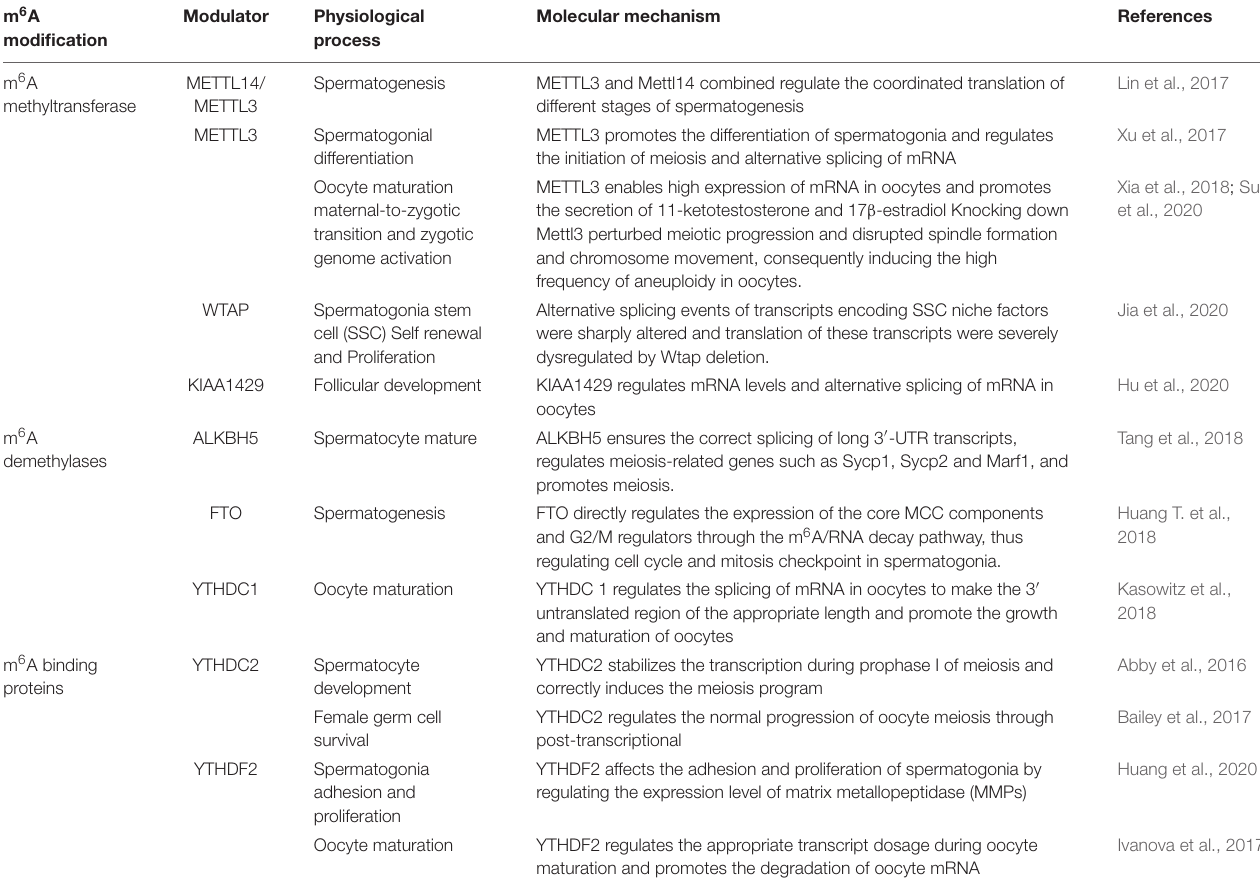
TABLE 2 | Role of m 6 A modulator on